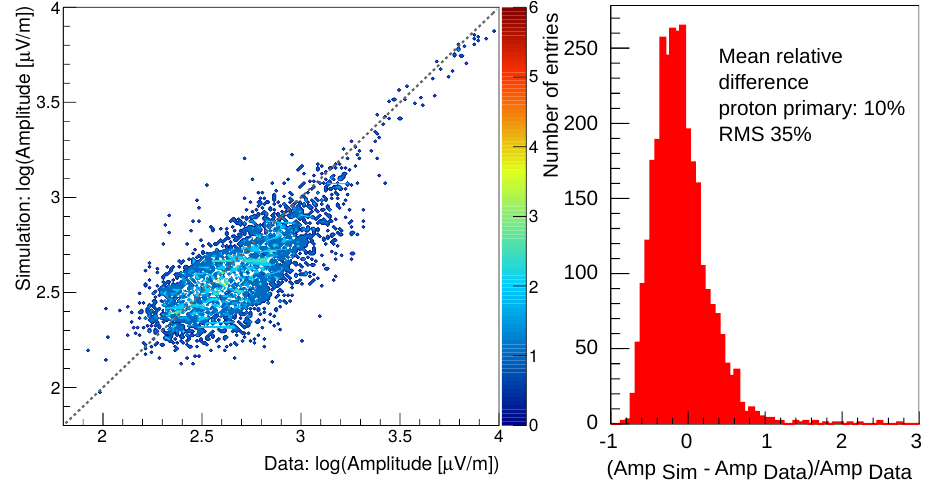
Figure 4. Comparison of measured and simulated events. In 427 horizontal showers 3065 AERA stations are above signal-to-noise threshold. The chosen simulation code is CoREAS. The systematic shifts and uncertainties need to be further